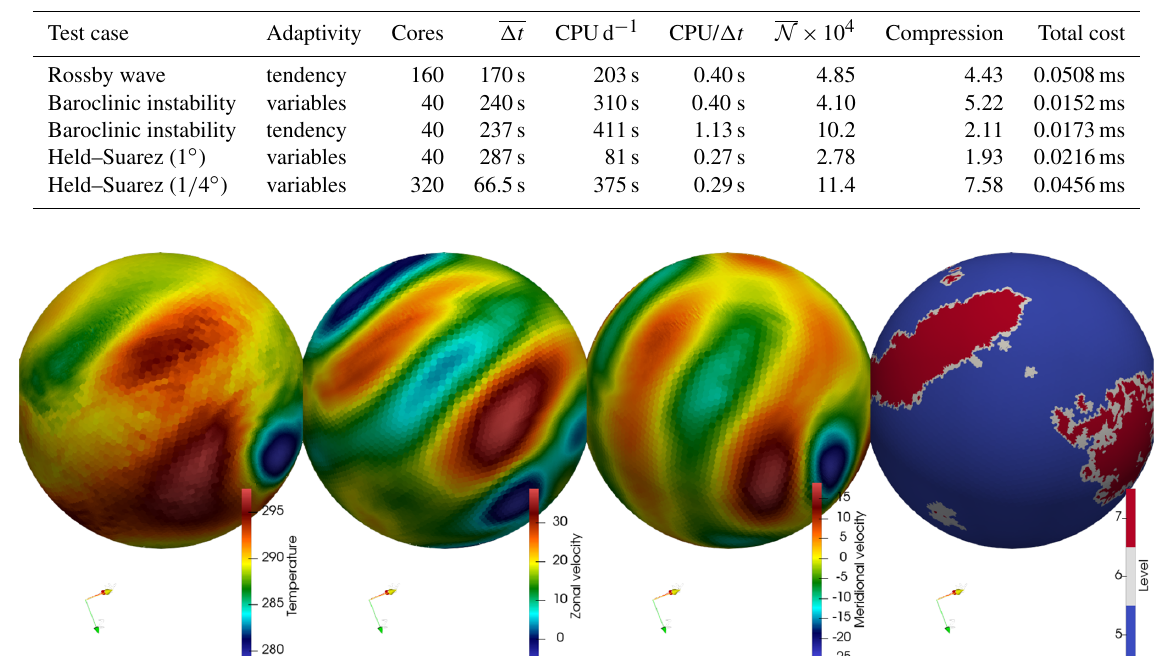
Table 2. Summary of actual computational performance for each of the test cases considered here. All runs were done on the Compute Canada machine niagara and the values shown are averages over the whole simulation. CPU is wall-clock time, N is the average number of active nodes (over all vertical levels and all scales), total cost is wall-clock time per time step multiplied by the number of cores (i.e. CPU hours per time step) per active node per vertical level. (Note that total cost does not take into account the speedup due to parallelism or adaptivity: it measures CPU hours per active node.) The Rossby wave run is more expensive because it uses a smaller patch size (4 × 4 rather than 8 × 8) in order to run on 160 cores with J min = 5. Please see the discussion at the beginning of Sect. 5.1 for an explanation of the trade-offs involved in patch size versus number of domains.